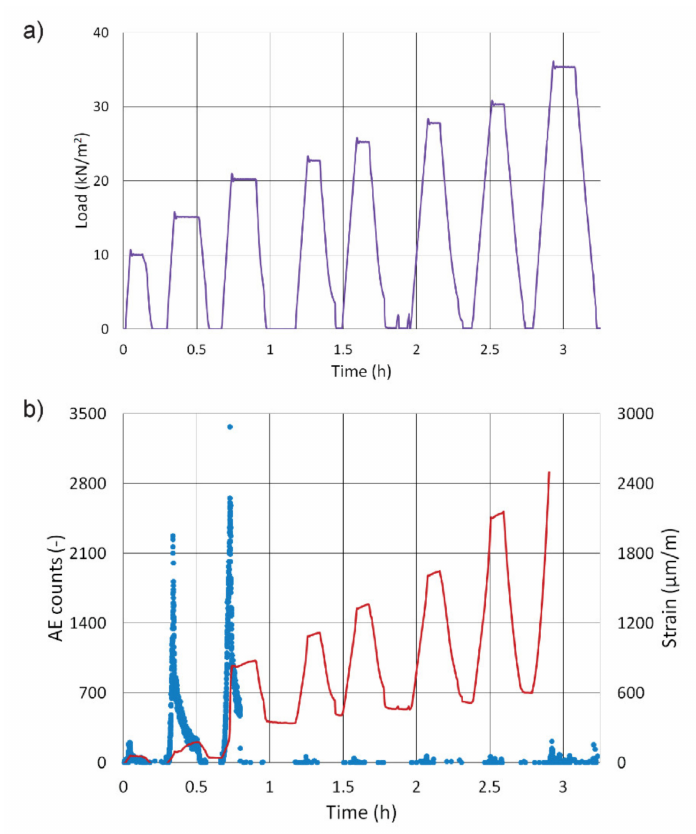
Figure 5. Real progress of loading ( a ); AE counts and relative strain of the concrete slab ( b